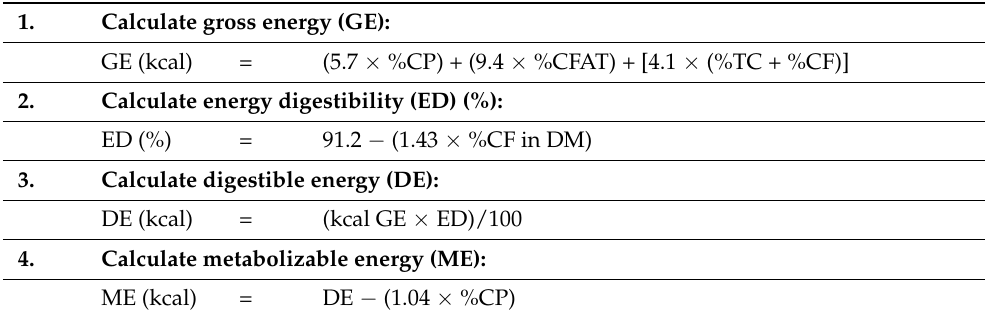
Table 2. Calculation of the metabolizable energy (ME, kcal) in dog foods. Adapted from